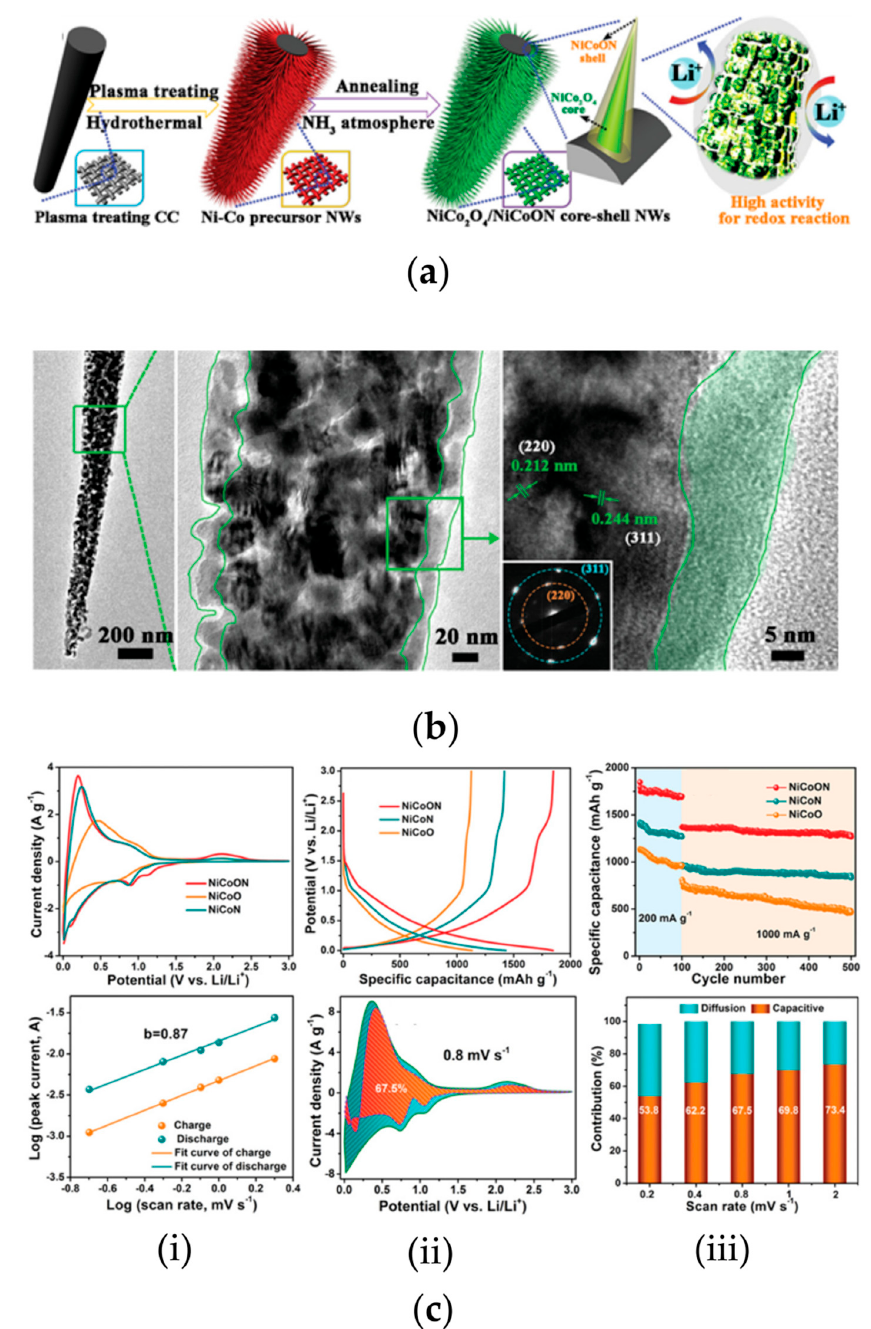
Figure 4. ( a ) Schematic of the fabrication procedure of the NiCo 2 O 4 /NiCoON core–shell nanowires and it as electrodes for redox reaction; ( b ) transmission electron microscopy (TEM) images in the first to panels (from left to right) and high- resolution TEM image of NiCoON in the third. The inset shows the corresponding selected area electron diffraction (SAED) pattern. ( c ) Electrochemical performance of Ni–Co-based nanocomposites: CV curves at 0.1 mV s − 1 . (i) Top panel: Galvanostatic Charge/Discharge (GCD) curves at 200 mA g − 1 ; (ii) top panel: cycling performance at 0.2 and 1.0 A g − 1 for 500 cycles; (iii) top panel: relationship between the logarithm of the cathodic peak current and the logarithm of the scan rate; (i) bottom panel: separation of capacitive and diffusion current at 0.8 mV s − 1 ; (ii) bottom panel: and charge storage contributions at different scan rates; (iii) bottom panel: CV curves of the NiCo 2 O 4 /NiCoON core–shell nanowires at in- creasing scan rate. Adapted from [71].